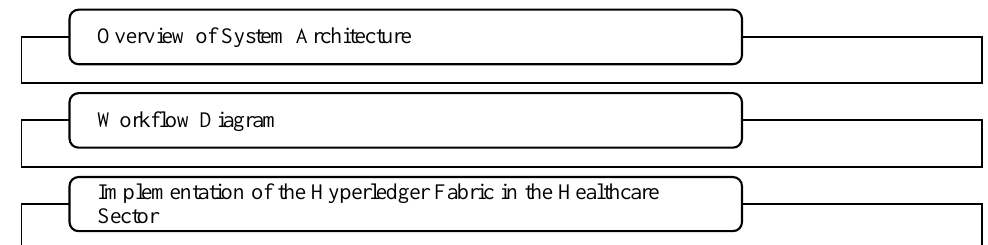
Workflow Diagram Implementation of the Hyperledger Fabric in the Healthcare Sector Figure 1: Summative steps of the Research Methodology Figure 1. Summative steps of the research Figure 1: Summative steps of the research methodology